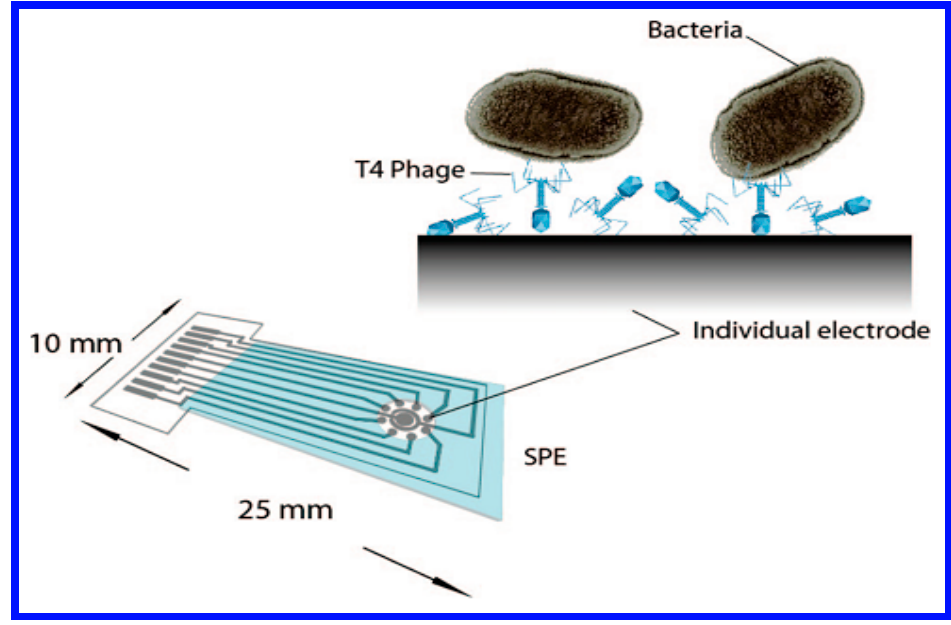
Figure 7. A schematic diagram of the assay for immobilizing phages onto electrochemical electrodes is shown. Reprinted with permission from [92].